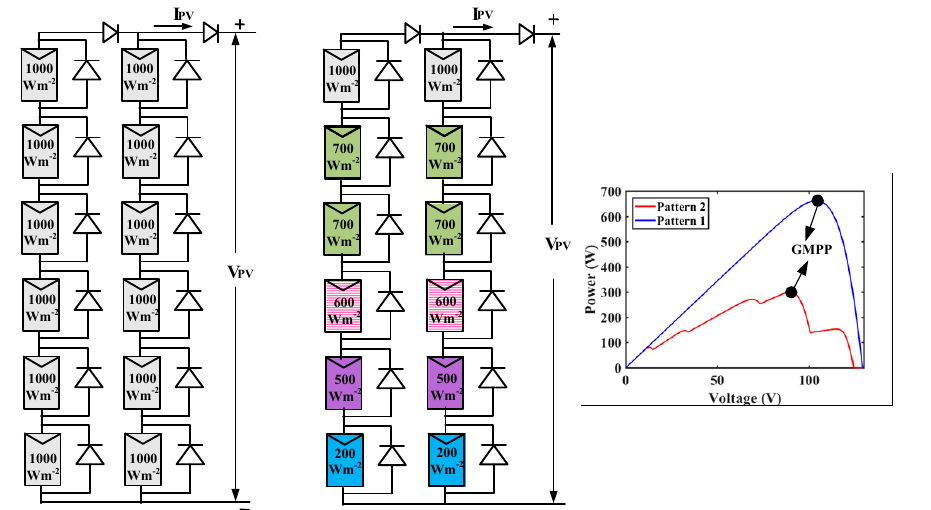
Figure 2. Occurrence of single and multiple power peaks during uniform and partial shade conditions.